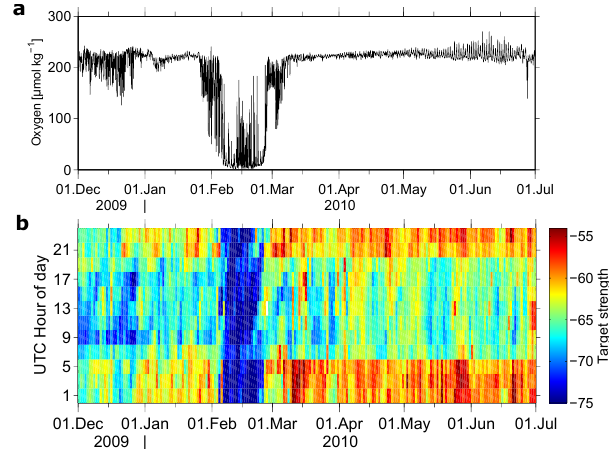
Figure 7. Time series of (a) oxygen at nominal 42m depth and (b) relative target strength between 65 and 70m depth against hours of the day (in dB). Target strength was calculated from the 300kHz acoustic Doppler current profiler data at CVOO. Minimal target strength during all hours of the day is seen during the passage of the low-DO anticyclonic-modewater eddy between 8 and 25 Febru- ary